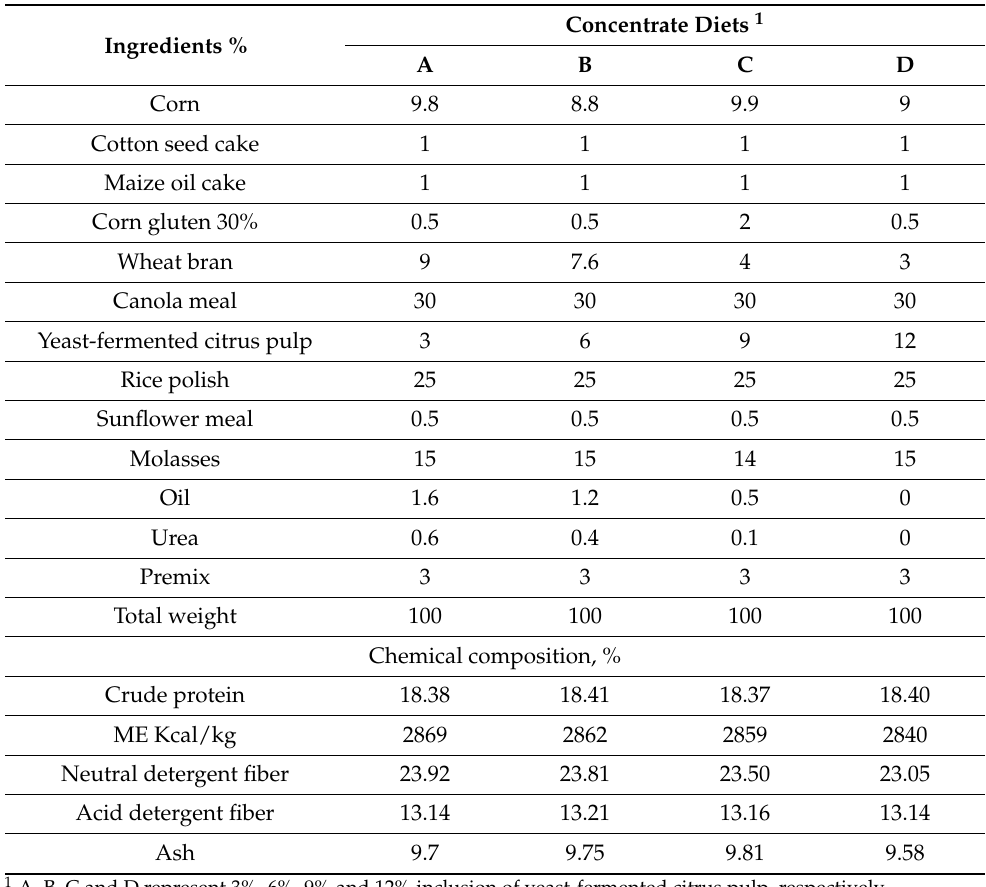
Table 1. Experimental diet and chemical